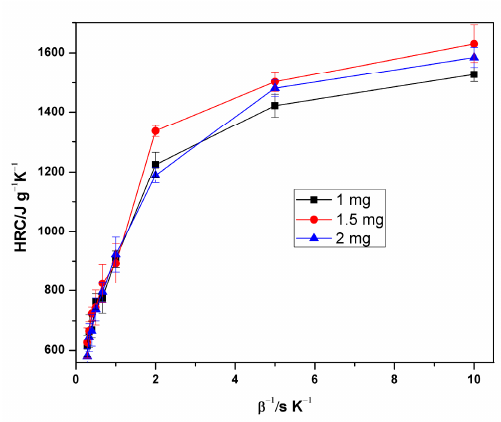
Figure 4. Plot of HRC versus inverse of heating rate for different sample masses.